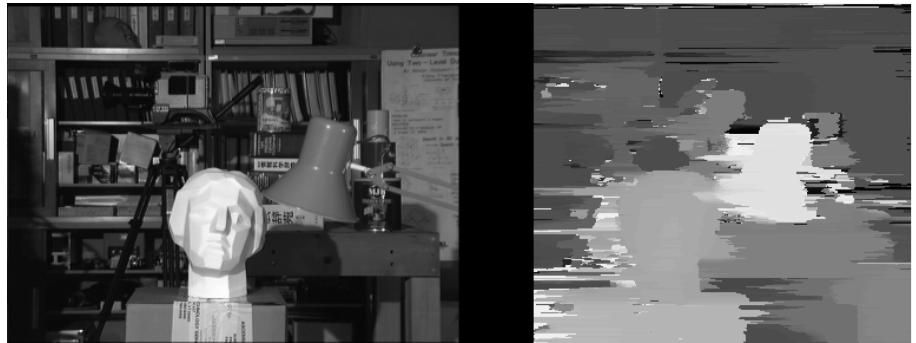
Figure 2. Tsukuba image from the Middlebury stereo benchmark and the resulting disparity map from our simplified implementation of [29].